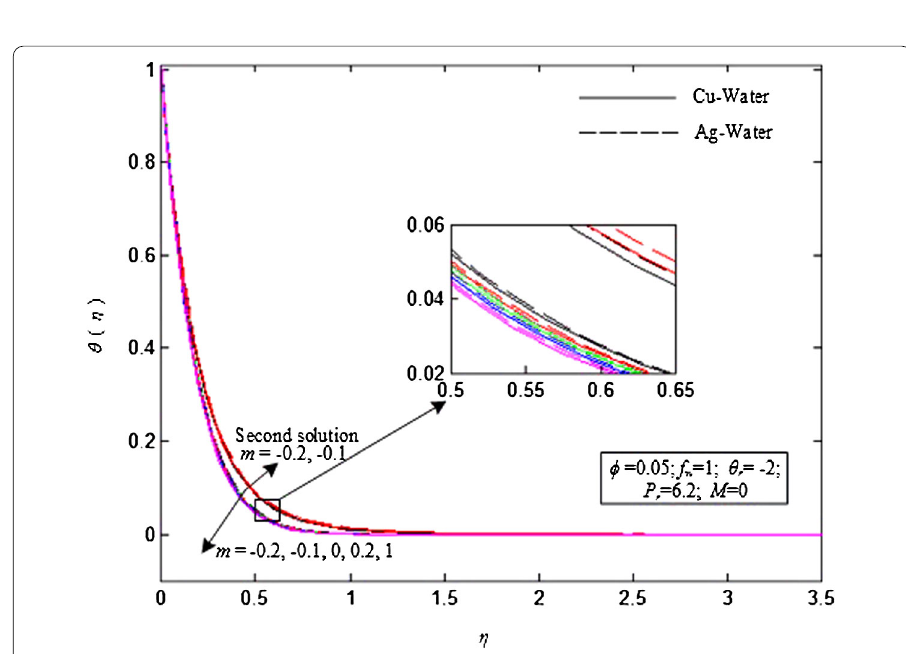
Figure 5 Temperature profile of Cu/ Ag-Water nanofluids for representative values of m .